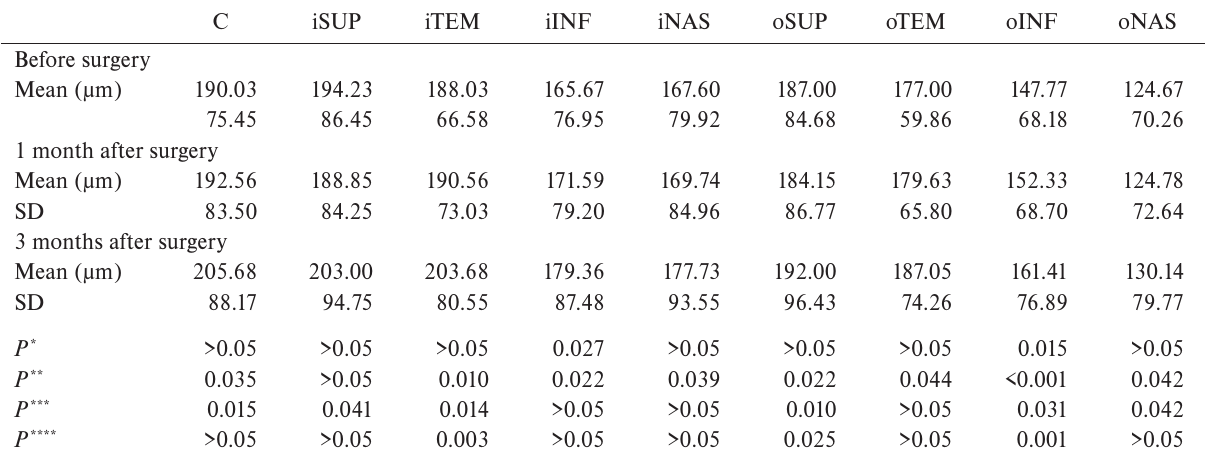
Table 2. The mean automatically measured SFCT in EDTRS sectors.